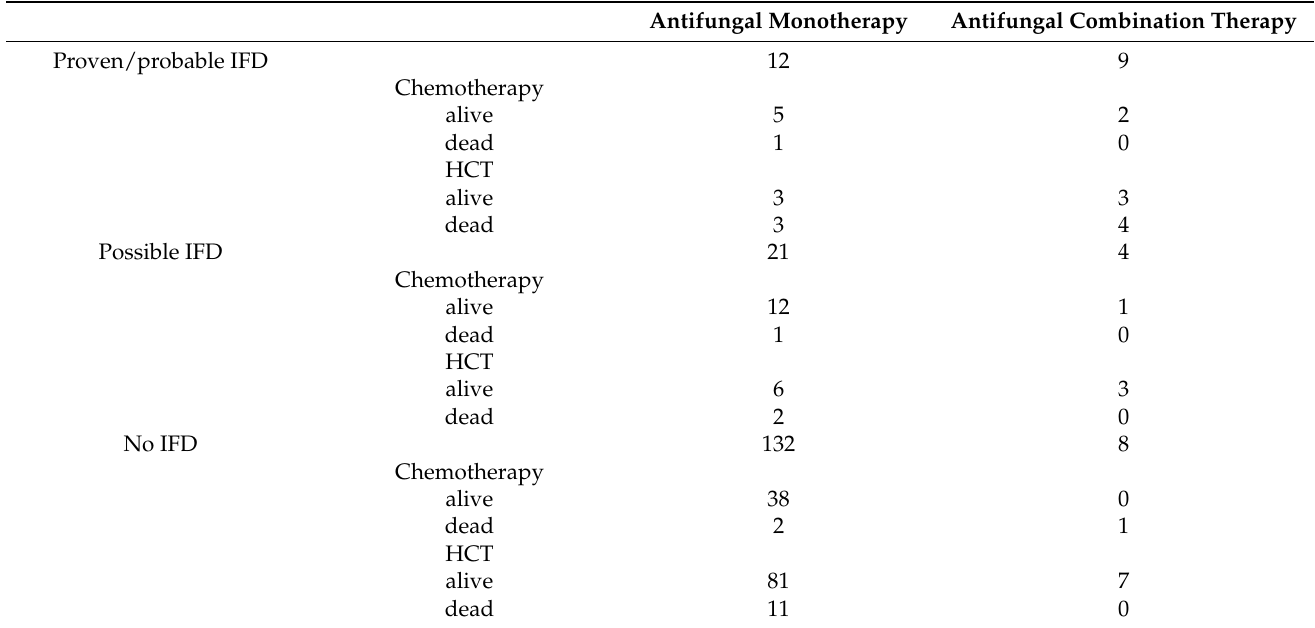
Table 3. Outcome of patients receiving antifungal monotherapy or antifungal combination therapy. Antifungal